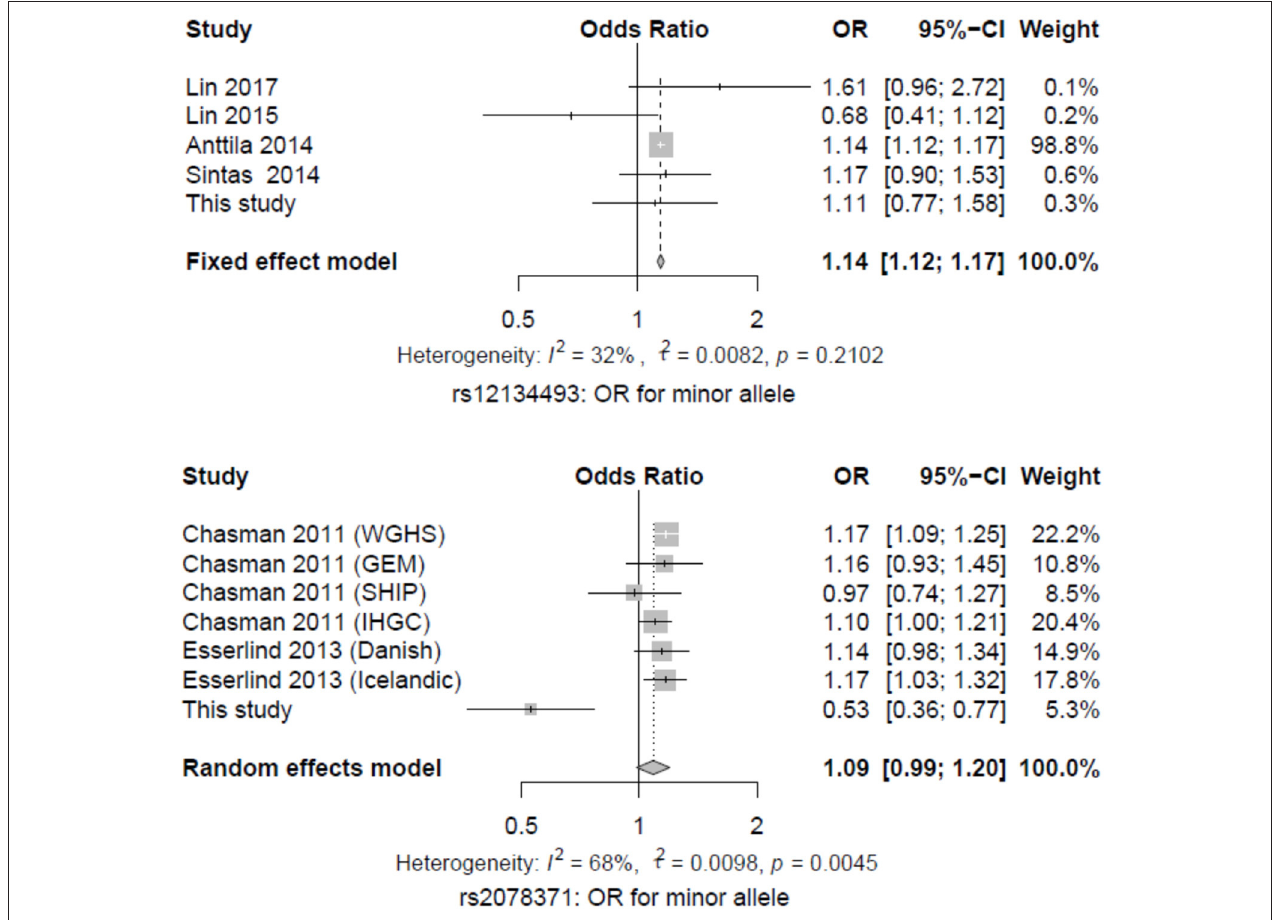
FIGURE 1 | Forest plot of migraine risk associated with the two SNPs in TSPAN2 . The estimates of ORs and 95% CIs were plotted with a box and a horizontal